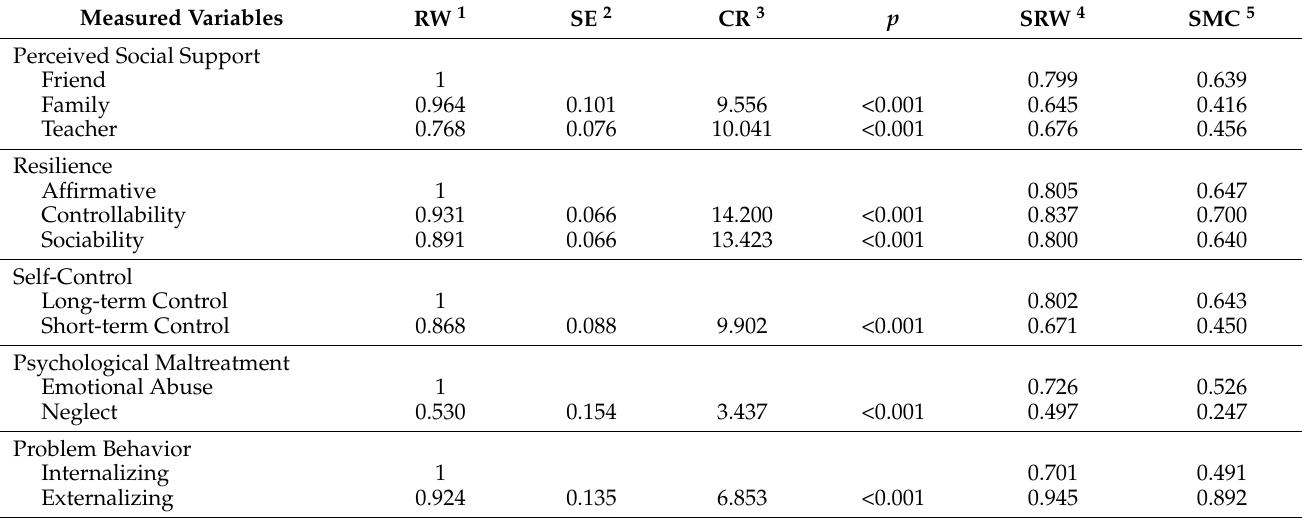
Table 4. Standardized Estimations of the Measured Variables.